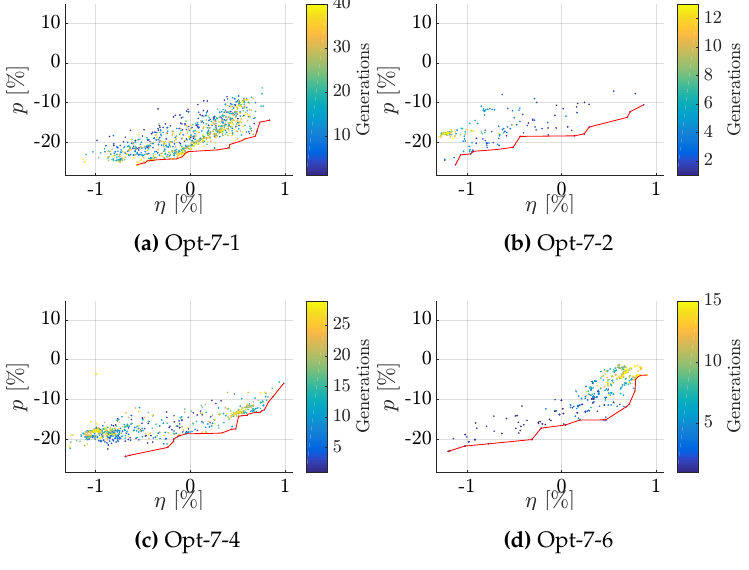
Figure 27. Pareto fronts for Opt-5 for η and pressure pulse objectives. ( a ) Opt-7-1; ( b ) Opt-7-2; ( c ) Opt-7-4; ( d ) Opt-7-6.